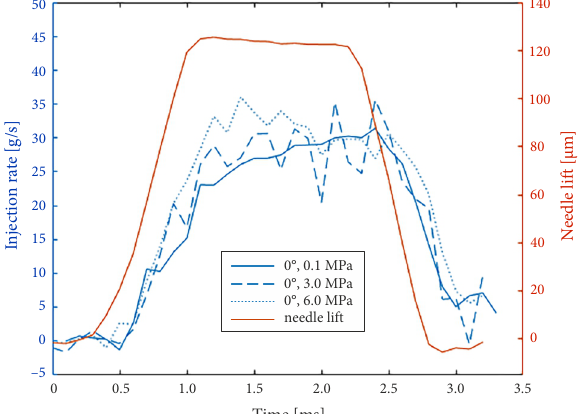
Figure 6. Measured injection rates and needle lift for 1500 min –1 , 200 N ⋅ m, 0° plug valve state, with different backpressures